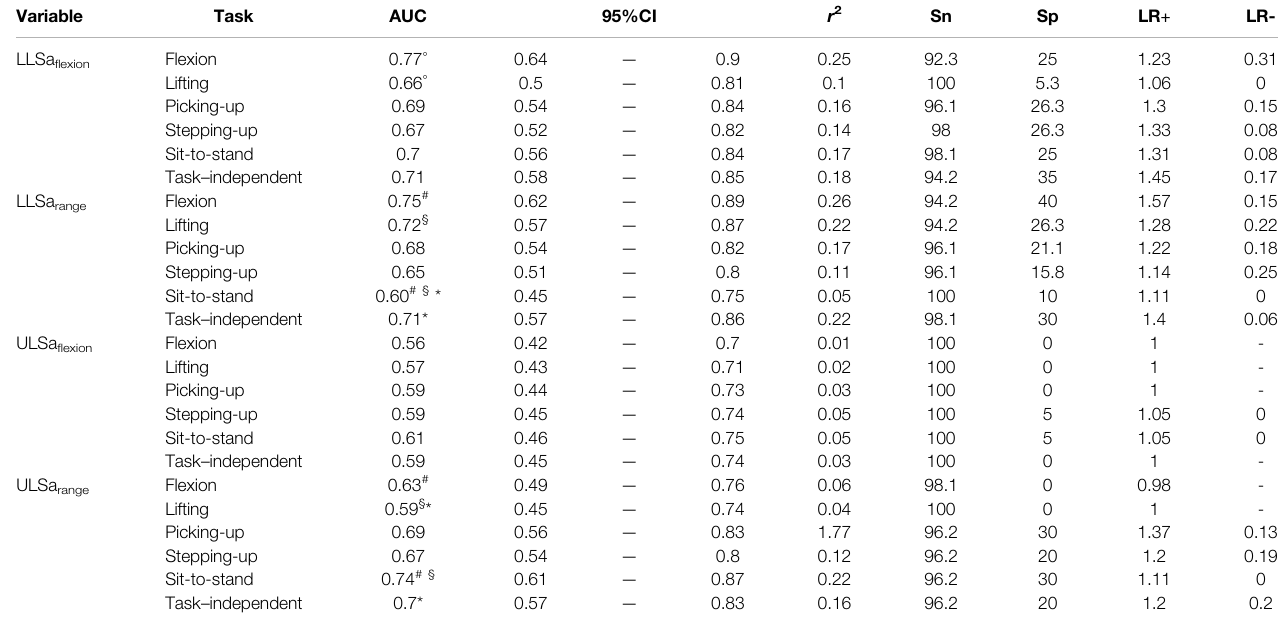
TABLE 2 | Logistic regression models for angular amplitude measures. AUC: area under the curve [with its con fi dence interval (95%CI)]; r 2 : coef fi cient of determination; Sn: sensitivity;Sp:speci fi city;LR+:positivelikelihoodratio;LR − :negativelikelihoodratio.Symbols( ° ,§,#, *)indicateadifferenceofAUC > 0.1betweentwotasksorbetweena speci fi c-task and the task – independent measure. Variable Task